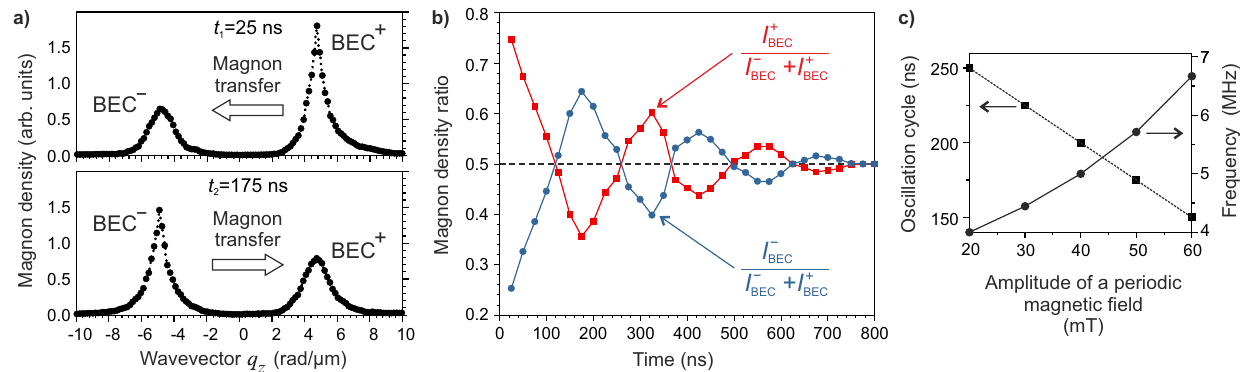
Fig. 3 Rabi oscillations in magnon Bose – Einstein condensate (BEC) within a magnonic crystal. a Wavenumber-dependent distribution of the magnon density at the bottom of spin-wave spectrum for two moments of time t 1 = 25 ns and t 2 = 175 ns. b Normalized peak magnon BEC densities I þ and q z ¼ (cid:2) q , respectively, as functions of time. c Periodicity of the Rabi oscillations as a function of the magnitude of a wavenumbers q z ¼ þ q BEC BEC spatially-periodic magnetic fi eld induced by the dynamic